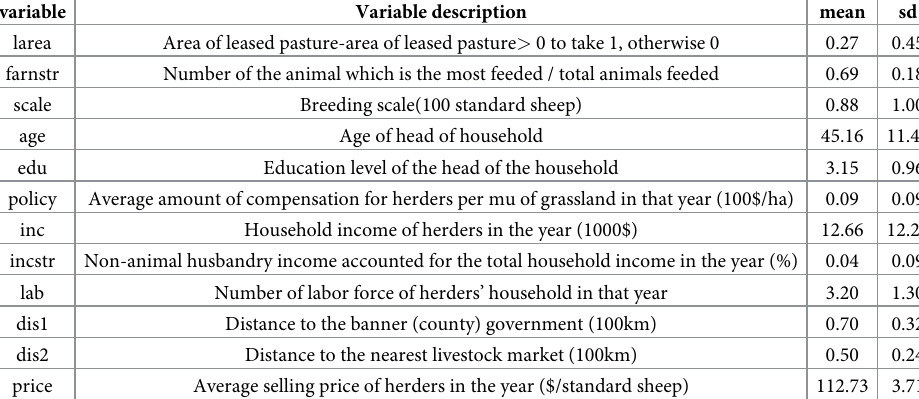
Table 2. Descriptive statistics of variables affecting the efficiency of breeding